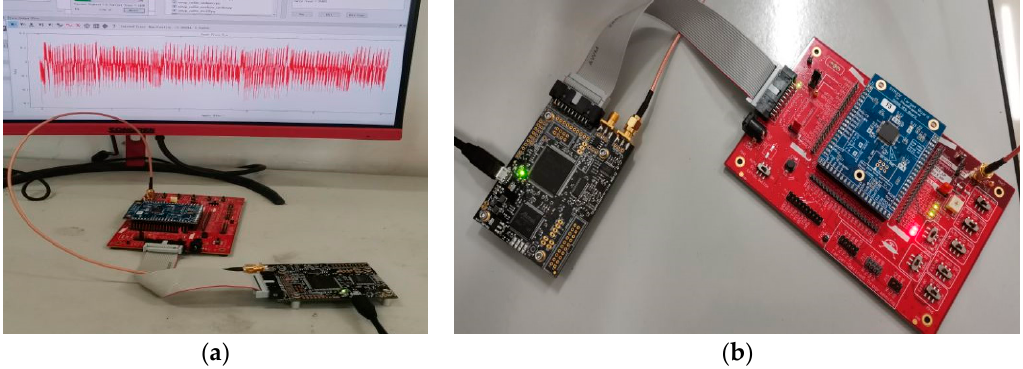
Figure 5. ( a ) Energy consumption data collection equipment; ( b ) target demo board.